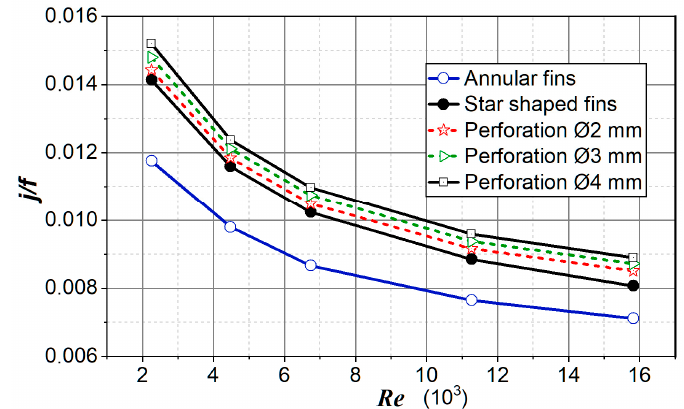
Figure 17. Area goodness factor.